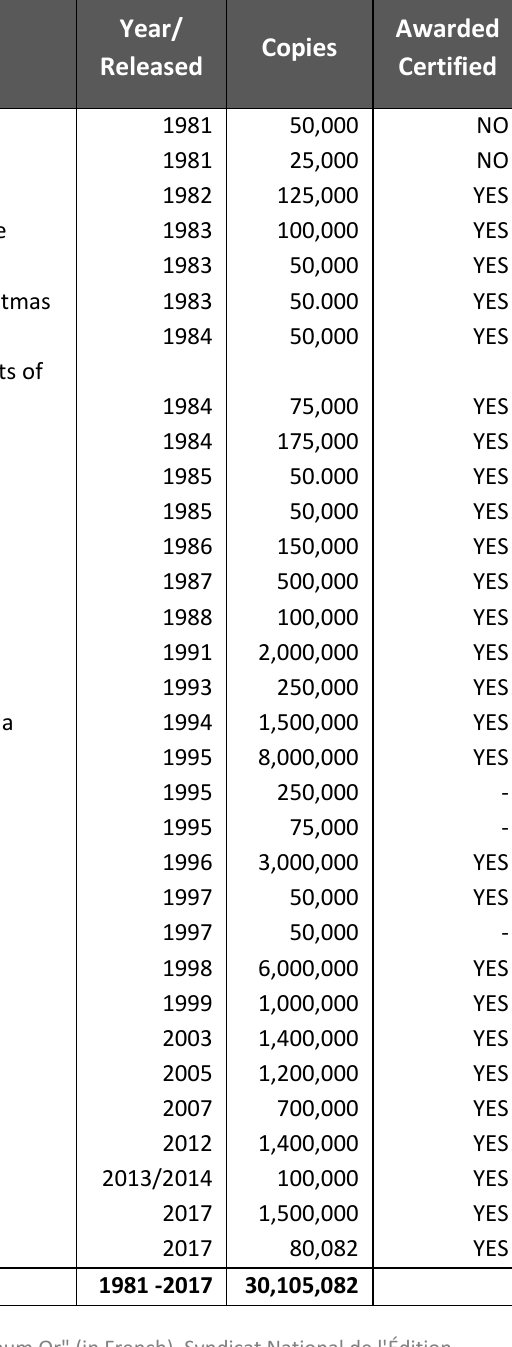
Table 2: Statistics on French album sales 1981 –